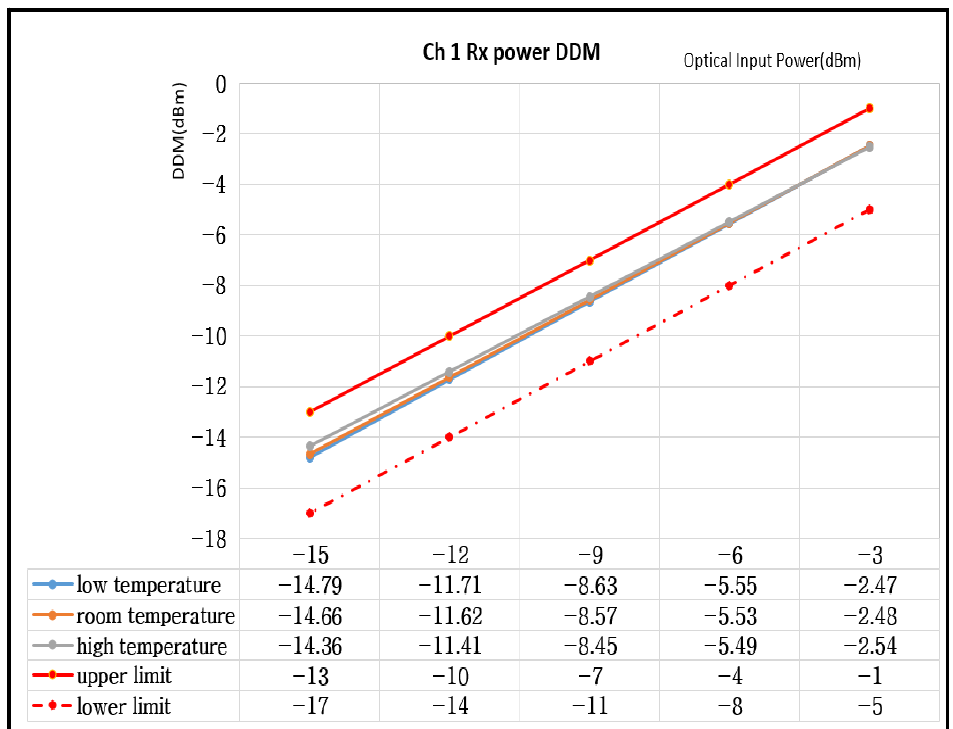
Figure 15. Optical PAM4 transceiver graph of Rx power digital diagnostic monitoring